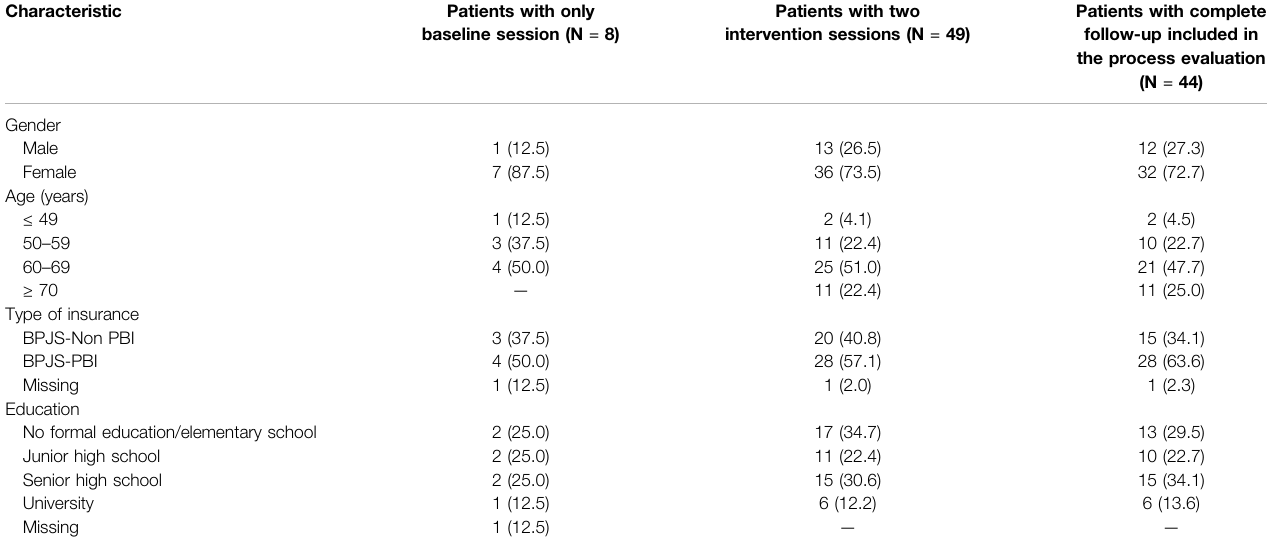
Patients with two intervention sessions (N = 49)